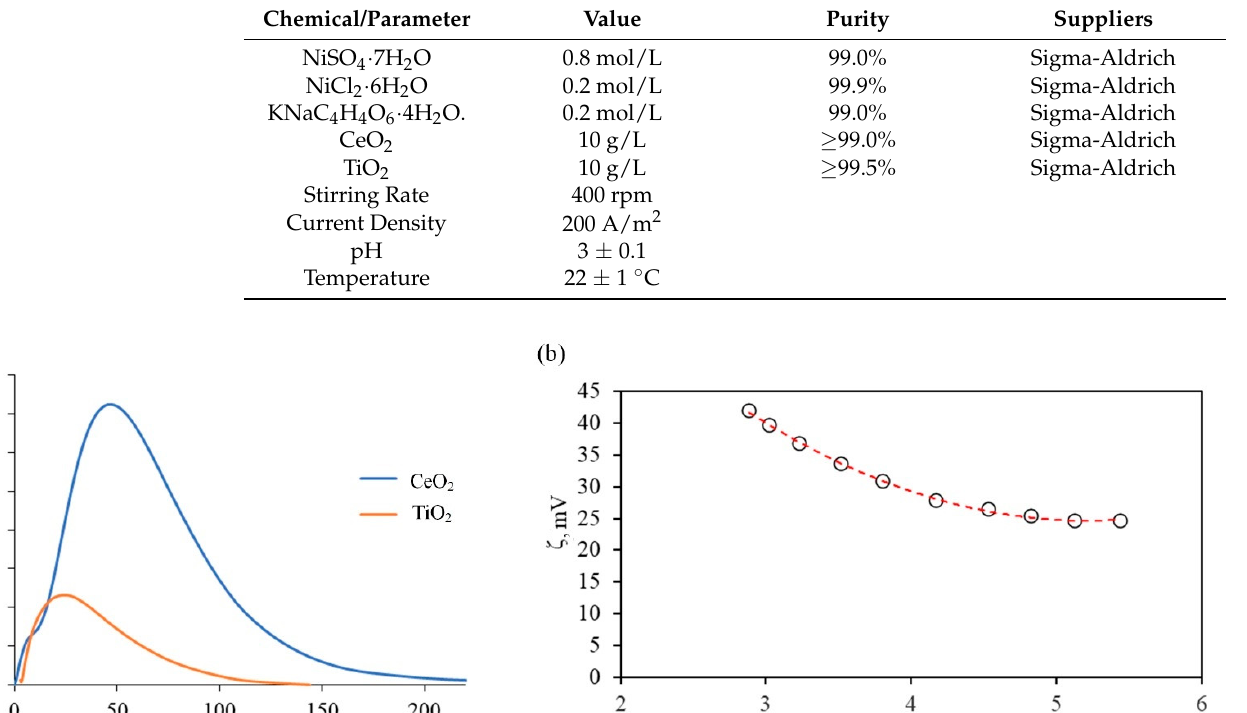
Table 3. Chemicals and conditions of electrolysis.